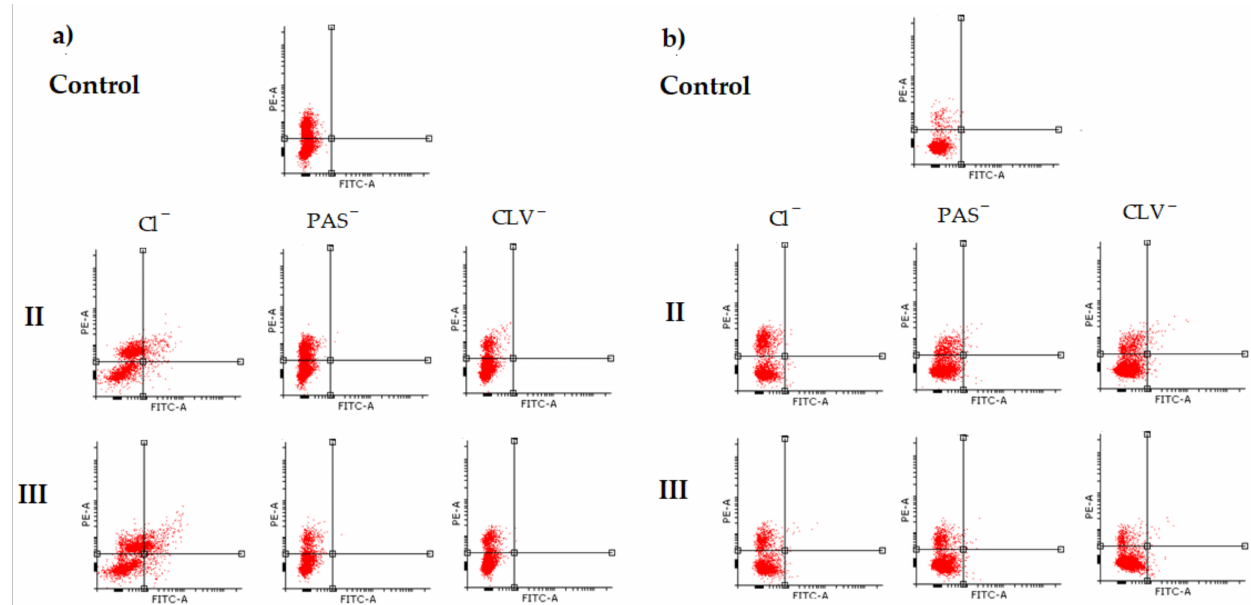
Figure 6. Representative plots of II and III cell populations determined by flow cytometric analysis in ( a ) A549 and ( b ) BEAS-2B cell